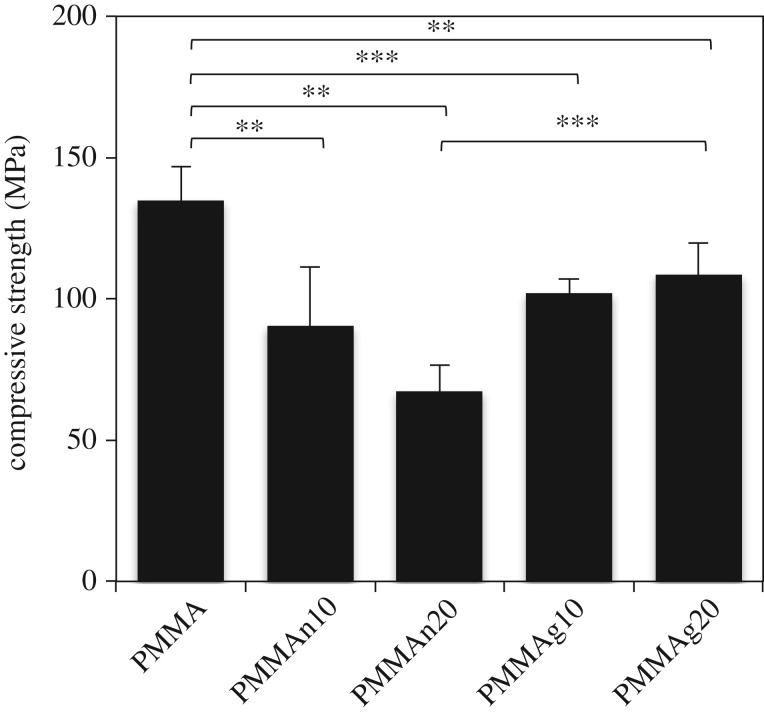
Compressive strength of PMMA-based composites. The mechanical property of the PMMA composite is tested with different percentages of nHAP and gHAP. The compressive strength decreased with an increase of nHAP loading. However, gHAP/PMMA maintained its compressive strength with an increase of gHAP loading. Five samples were tested, and the mean values were calculated. **p < 0.01 and ***p < 0.001.